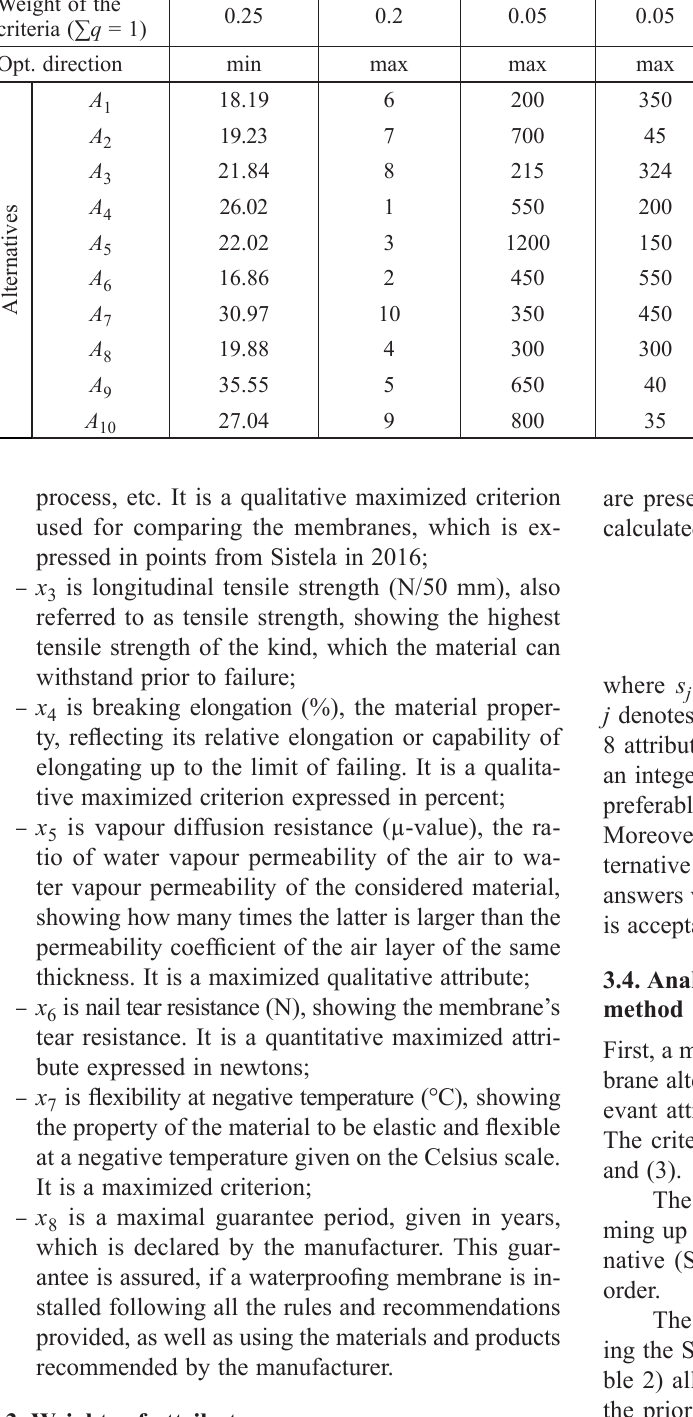
Table 1. The initial data of decision matrix ( A i alternatives, X i decision attribute) The cost of Criteria one sq. m of Units of measure Weight of the criteria (∑ q = 1) Opt.